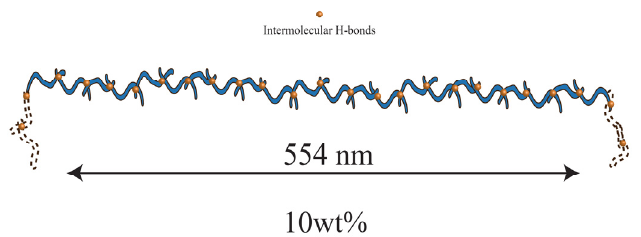
Figure 3. Schematic diagram of hydrogen bond mesh in PVA solution.